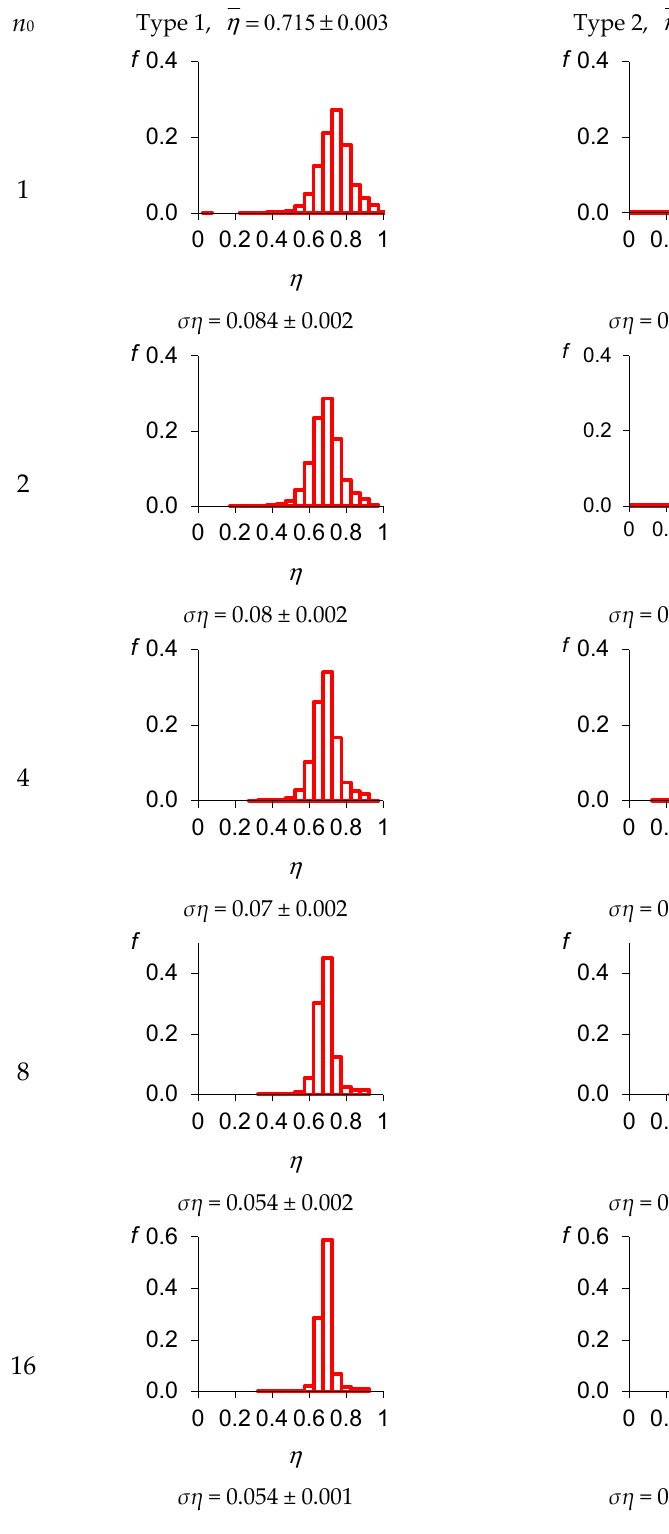
Figure 5. Dependences of porosity informative parameters and local volume size n 0 in pixels. Local volumes with a size over 1 mm are of great interest for practical applications. The XCT images in Figure 6 show the homogeneity of the pore distribution by the average porosity η in local volumes with d size for all Using the developed algorithm, the pore distribution homogeneity is calculated for local volumes 1, 2, 3, and 5 mm in size. The pore distribution homogeneity is calculated by η and ση parameters. Nonnormative compaction and porosity are analyzed for the average porosity in local volumes. In the case of the STD porosity, we study its increase, since its